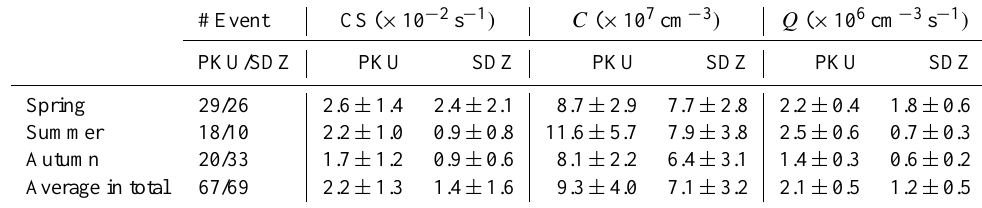
Table 2. Statistics of condensable vapor concentration ( C) , condensation sink (CS) and source rate ( Q) during the NPF event over the three seasons and whole measurement period. CS is the median value during the time frame for determination of